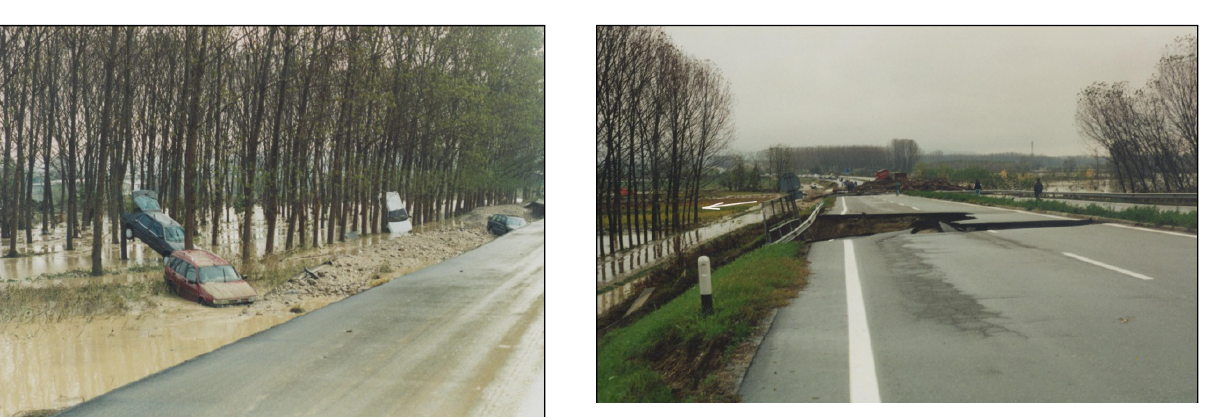
Fig. 14. A large failure caused by the undercutting floodwaters Fig. 14 – A large failure caused by the undercutting floodwaters blocked the Asti-Cuneo Highway. In the background, the light sub- blocked the Asti-Cuneo Highway. In the background, the light Fig. 14 – A large failure caused by the undercutting floodwaters sidence of the highway where the waters overflowed (K in Fig. 2) subsidence of the highway where the waters overflowed (K in Fig. blocked the Asti-Cuneo Highway. In the background, the light 2) left a large accumulation of uprooted trees. left a large accumulation of uprooted subsidence of the highway where the waters overflowed (K in Fig. 2) left a large accumulation of uprooted trees.